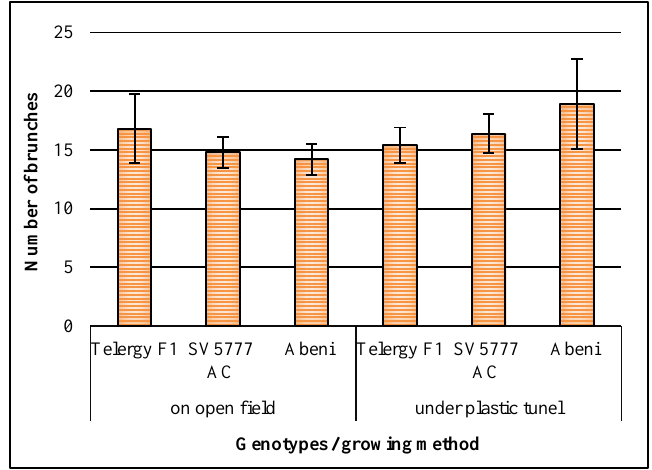
Figure 4. Number of bunches by different genotypes and growing methods The cauliflower needs balanced water and nutrient supply,